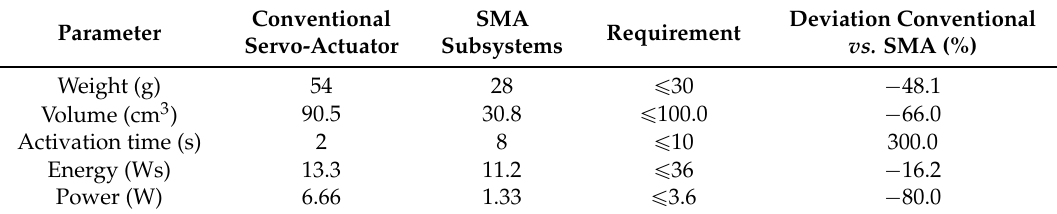
Figure 15. Conventional SMA deployable system comparison vs. requirements. Table 4. Performance comparison.